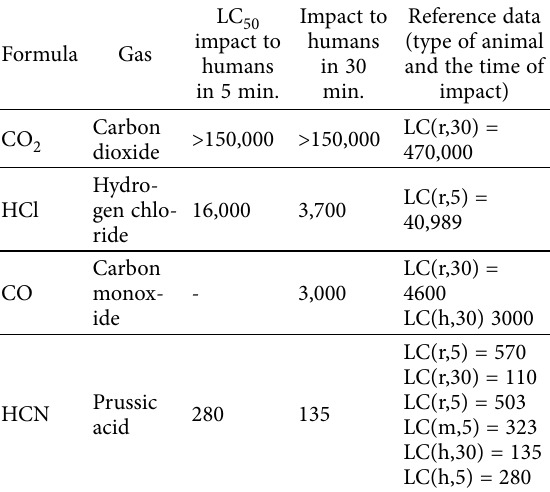
Table 1. Toxicity of various combustion products